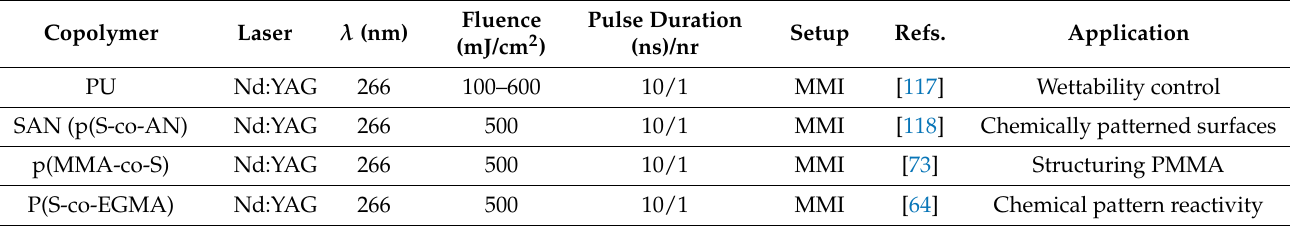
Table 4. Summary of parameters used in DLIP with copolymers.